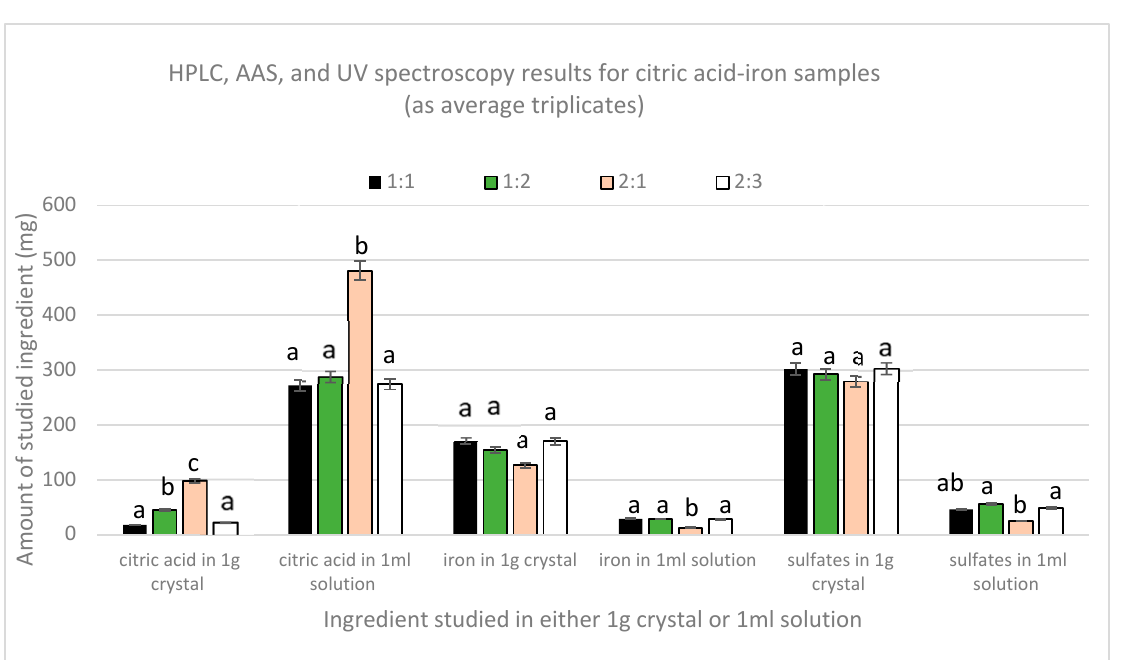
Figure 2. Average amount (mg) of citric acid, iron, and sulfates in crystal (1 g) or solution (1 mL) .